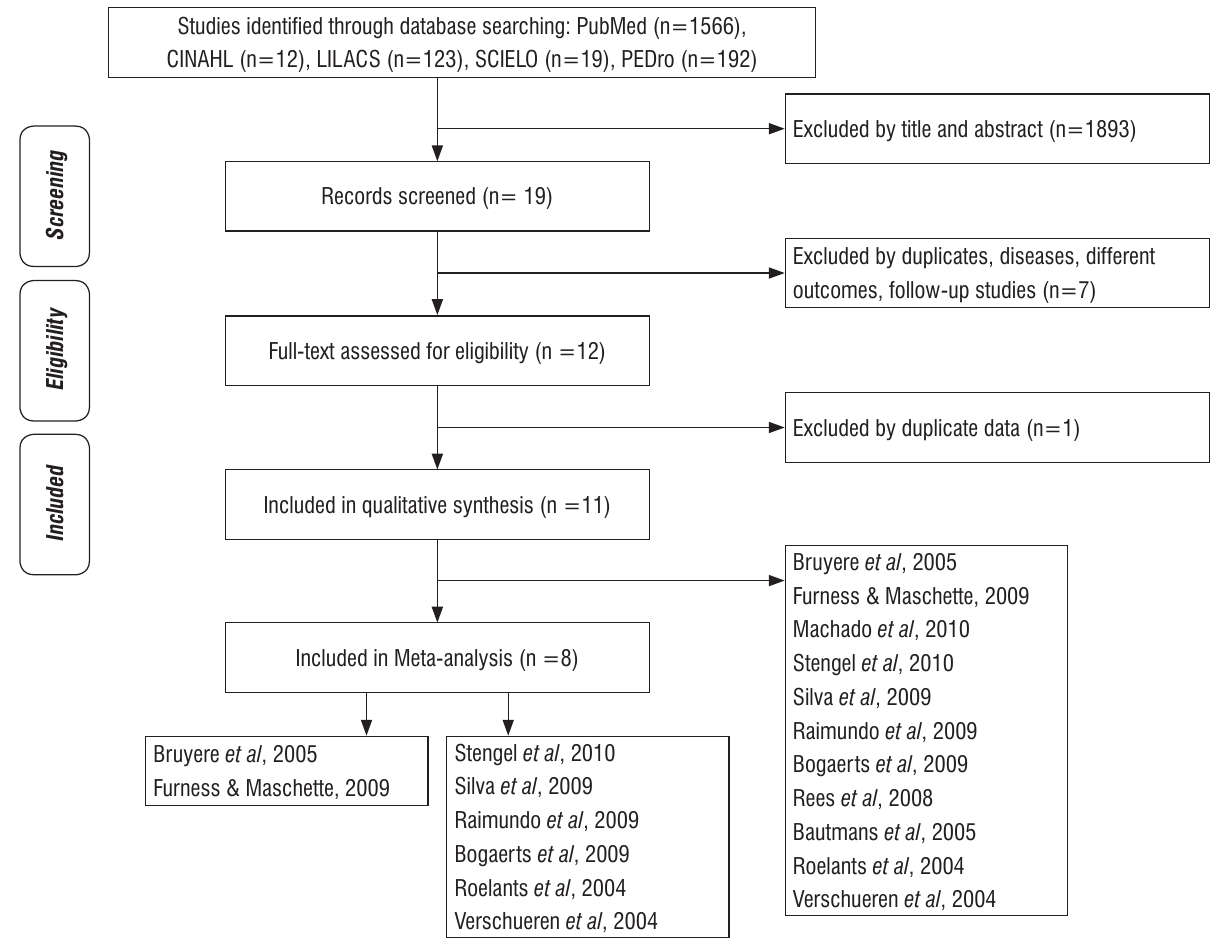
Figure 1 - Search and selection of studies for systematic review in accordance with PRISMA. Strength